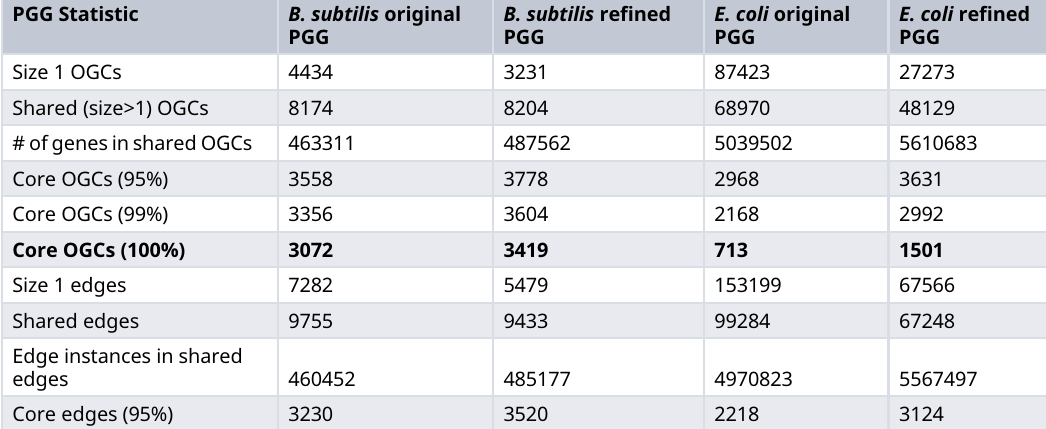
Table 2. Pan-genome graph statistics for B. subtilis and E.